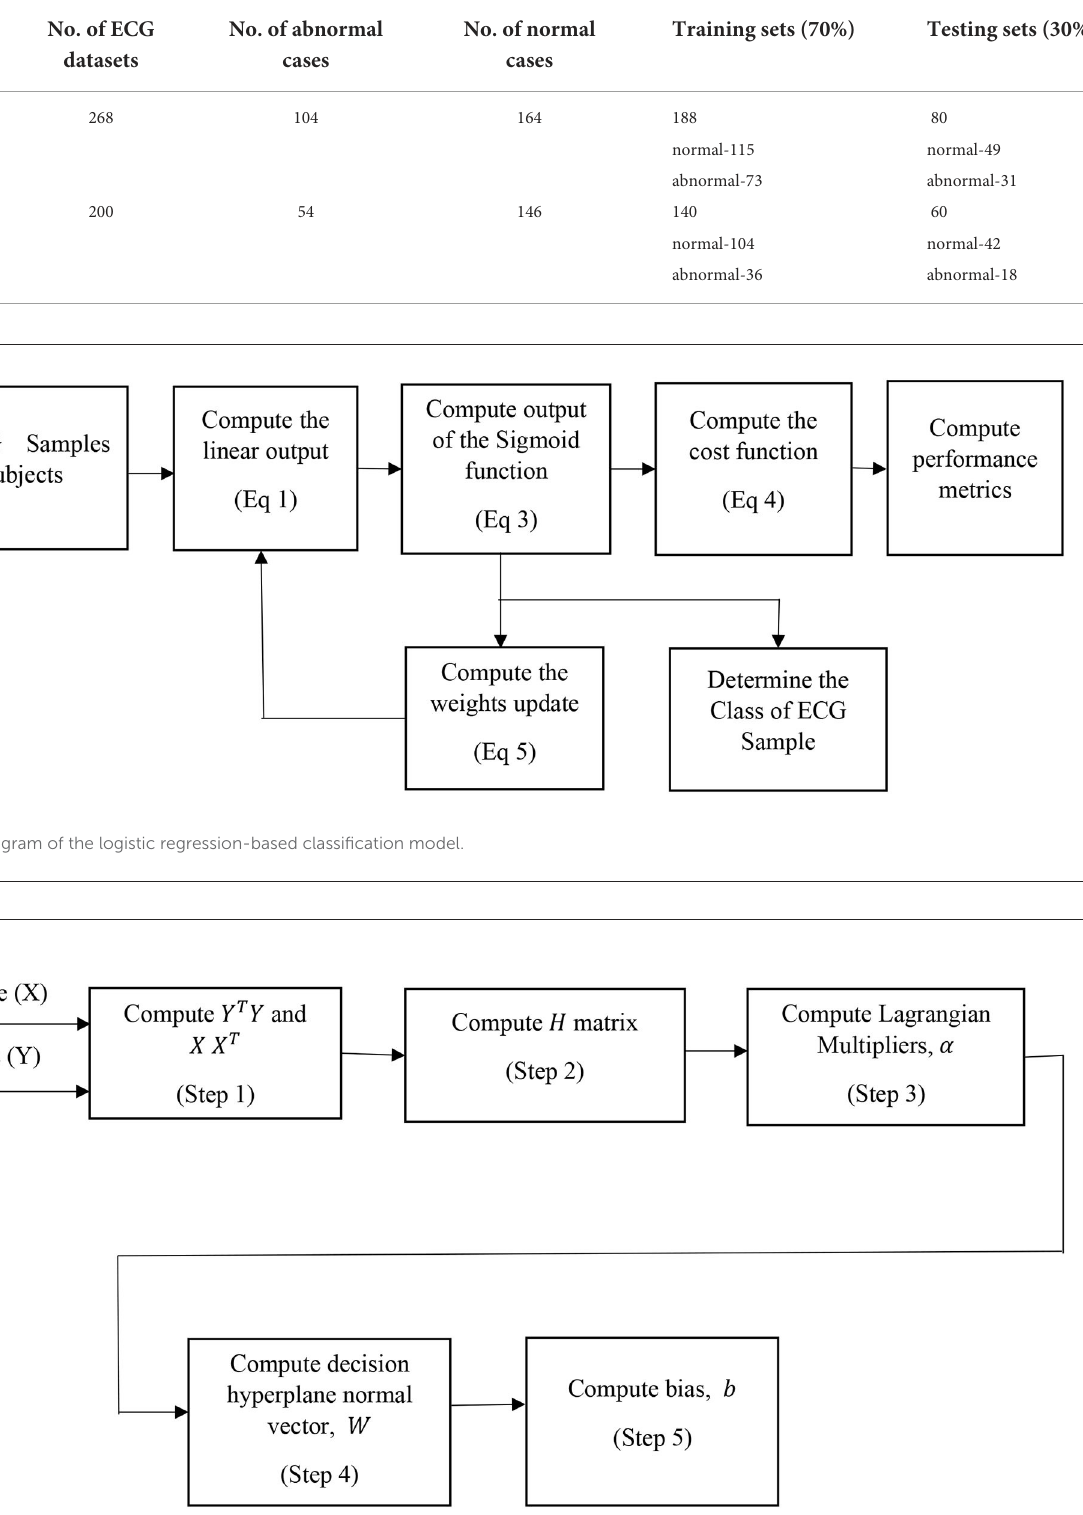
TABLE 1 Materials used for training and testing the ML classification models.